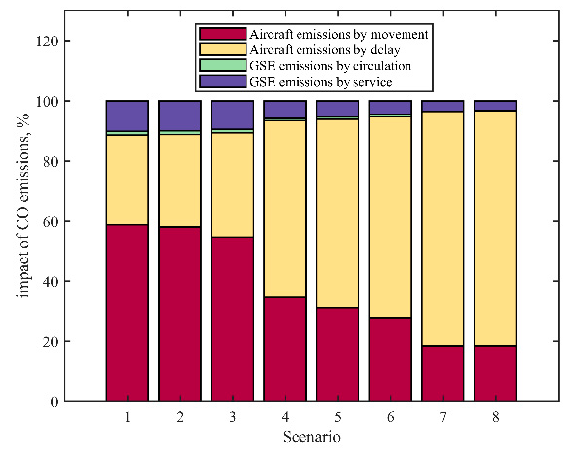
Figure 8. CO impact per group and process.